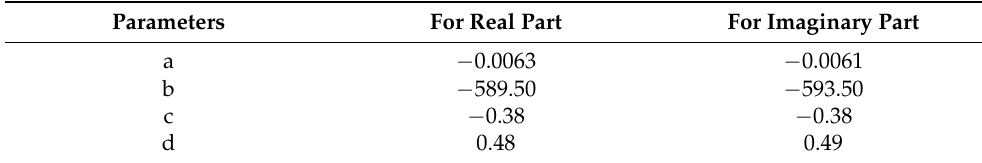
Table 1. Parameters of the fitted modified Sigmoid functions. Parameters